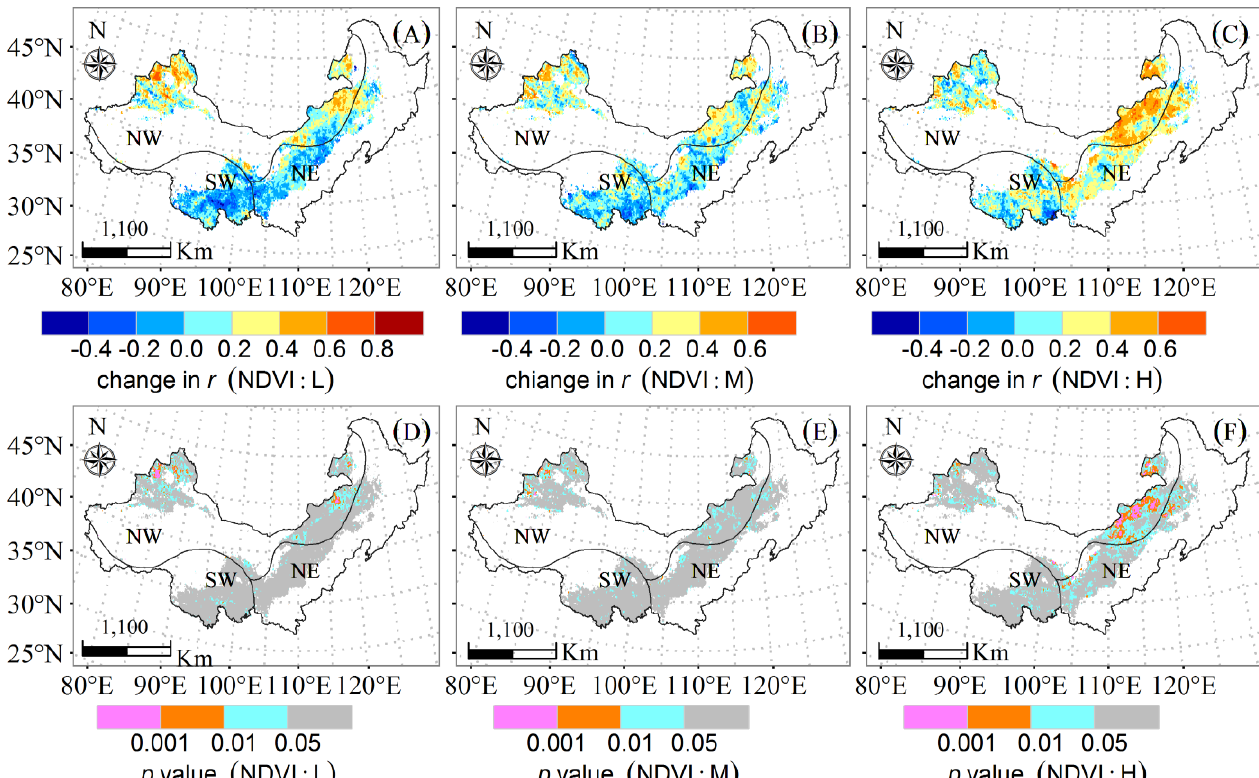
Figure 6. Distributions of correlation coefficients ( r ) between NDVI and light (L, A ), moderate (M, B ), and heavy (H, C ) precipitation, and the corresponding statistical p values between NDVI and light ( D ), moderate ( E ), and heavy precipitation ( F ), respectively, in northern China during